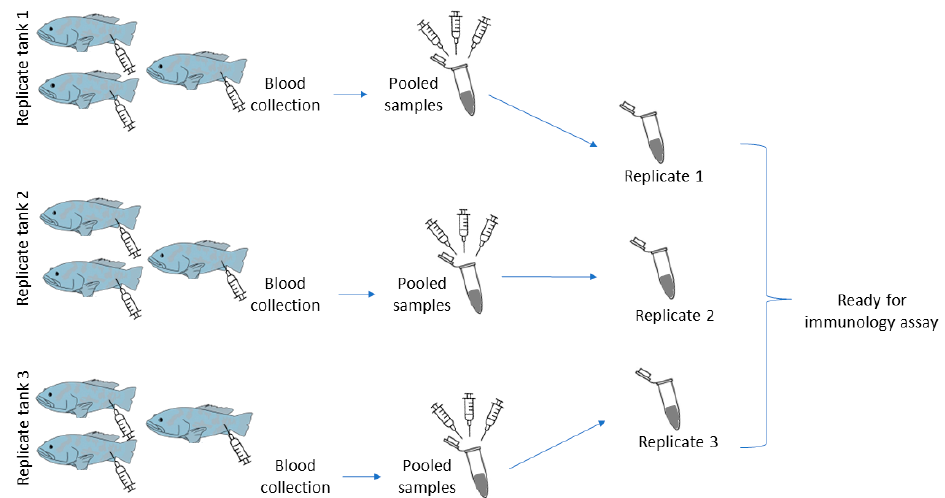
Figure 1. Diagram for blood sampling after feeding trial and after post-bacterial challenge. The same sampling procedure was carried out for spleen collection (pooled sample n = 3).